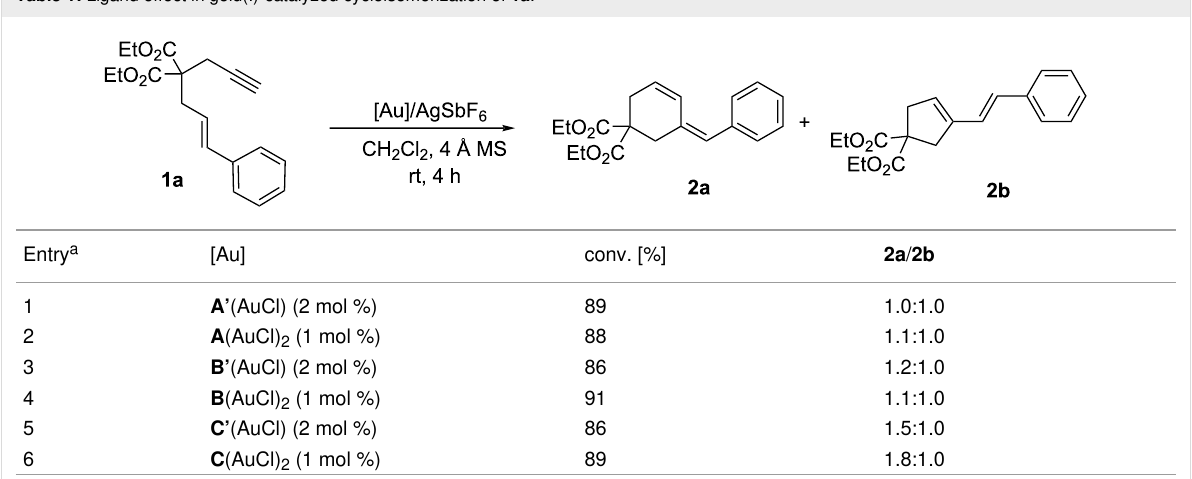
Table 1: Ligand effect in gold(I)-catalyzed cycloisomerization of 1a .